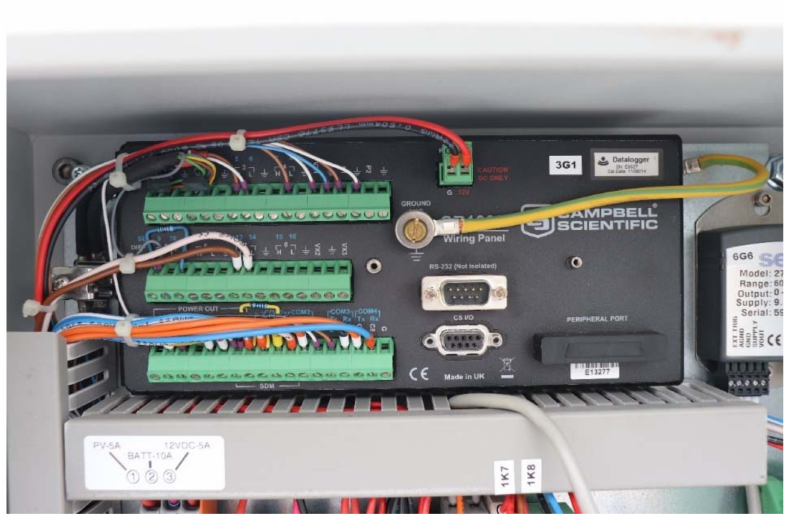
Figure 4. CR1000 data logger installed at UET Peshawar’s weather